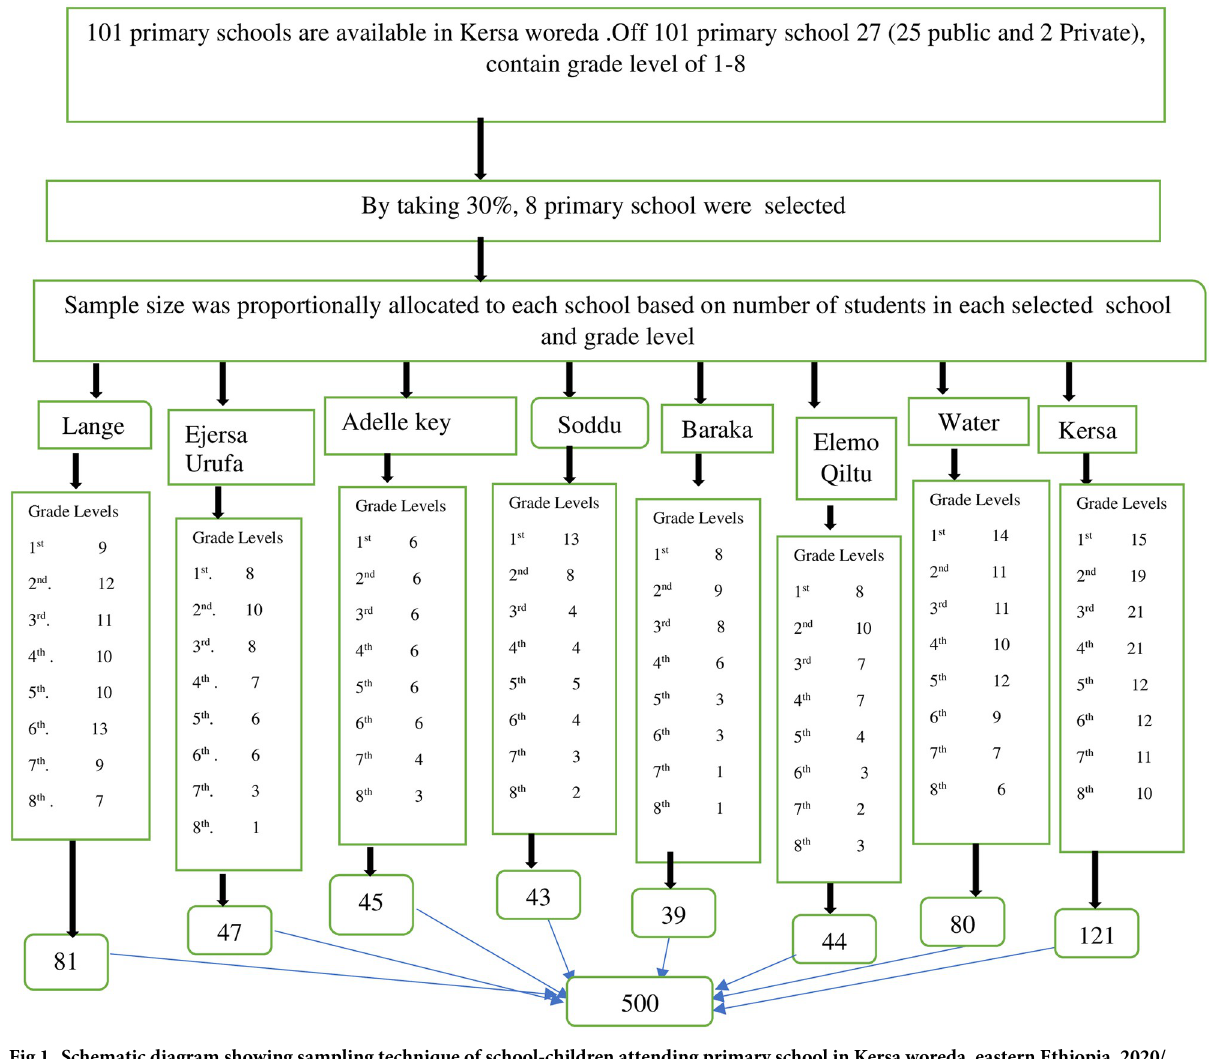
Fig 1. Schematic diagram showing sampling technique of school-children attending primary school in Kersa woreda, eastern Ethiopia, 2020/ 2021.